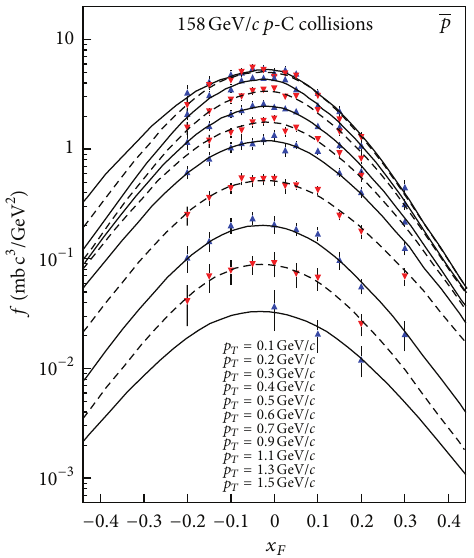
Figure 2: Feynman variable distributions of antiprotons in 𝑝 -C collisions at 158GeV/ c . The symbols represent the experimental data oftheNA49Collaboration[18]atdifferent 𝑝 𝑇 ,andthecurvesareour results calculated by the multisource thermal model.